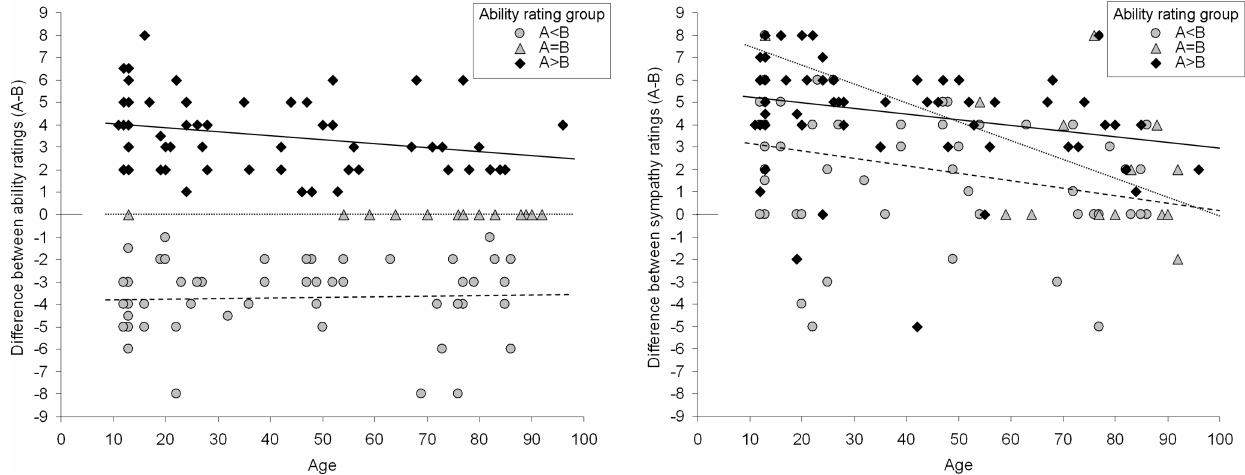
Figure 1. Scatter plots of participants’ ability and sympathy ratings depending on age, and depicted regarding the three ability rating groups (A < B, A = B, A >